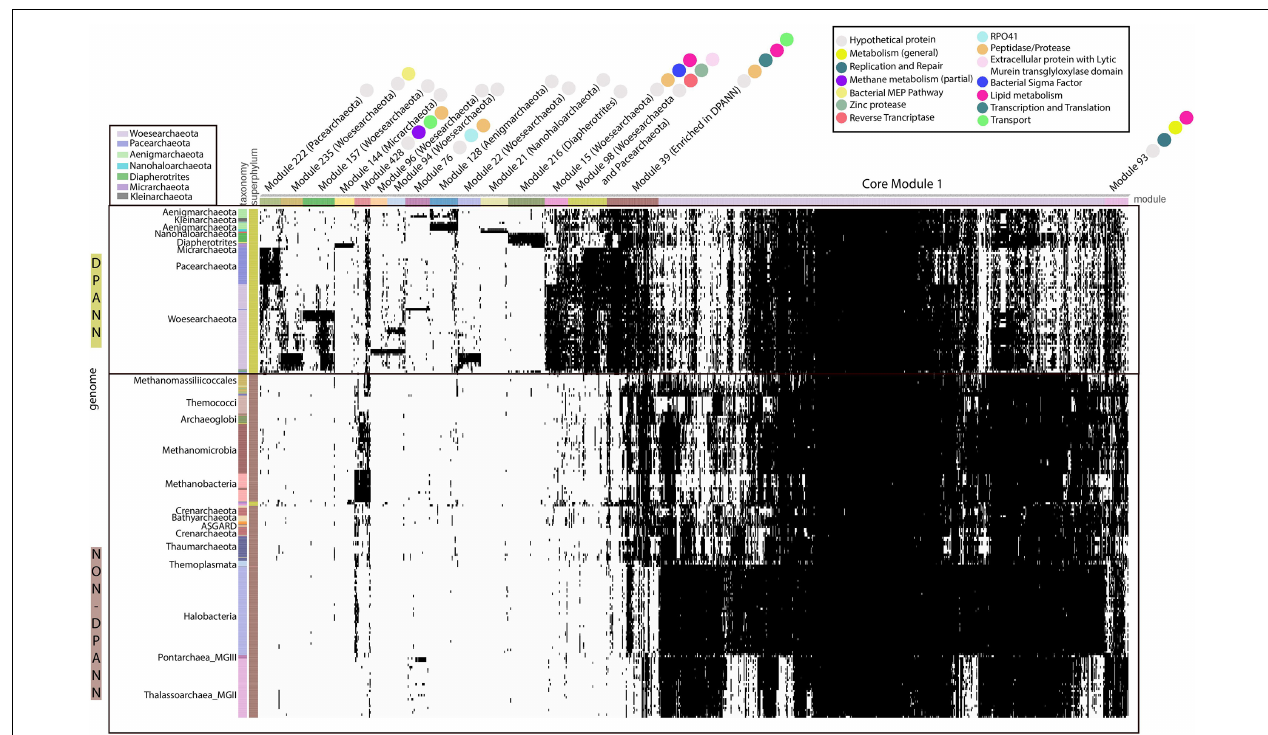
FIGURE 2 | Distribution of 17 modules (1143 Protein families) in DPANN genomes. The distribution of 1143 protein families (columns) in representative genomes (rows) from Archaea. Data are clustered based on the presence (black) and absence (white) profiles (Jaccard distance, complete linkage). Pathway or function for each protein family is indicated by a colored